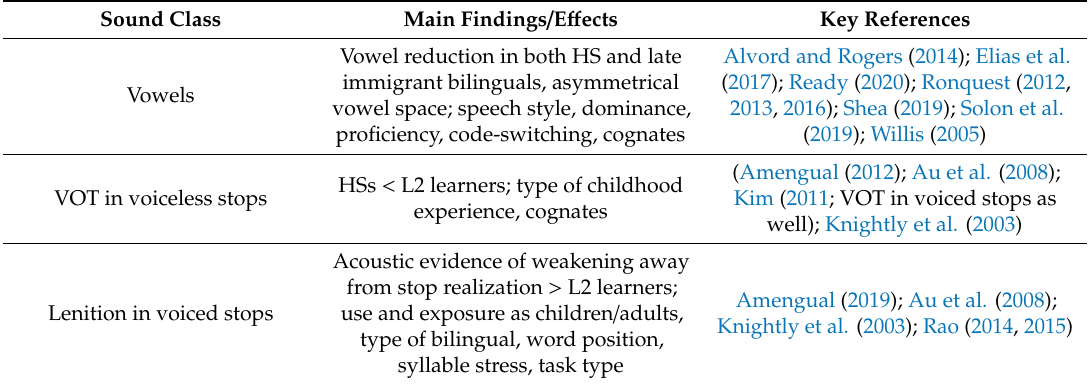
Table 1. Summary of relevant studies on the vowels and stop consonants of heritage Spanish in contact with